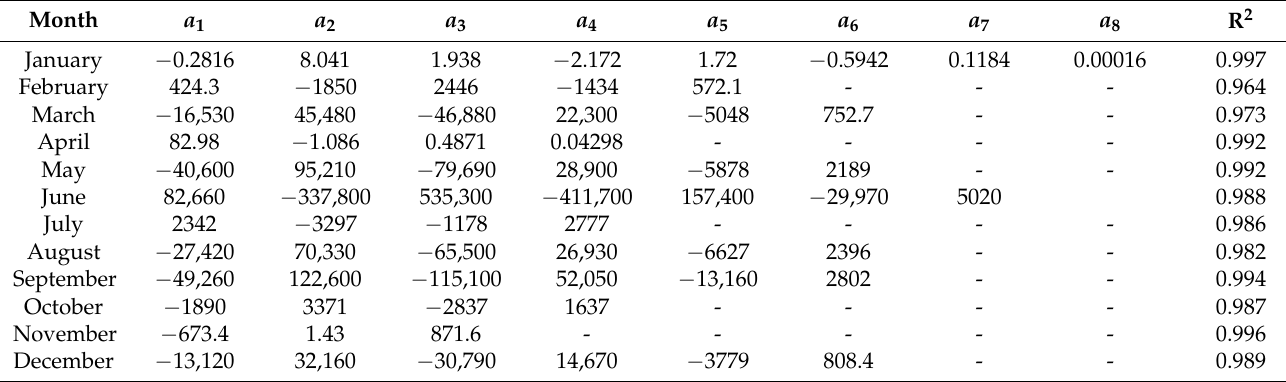
Table A6. Specific parameters of Sinan section.